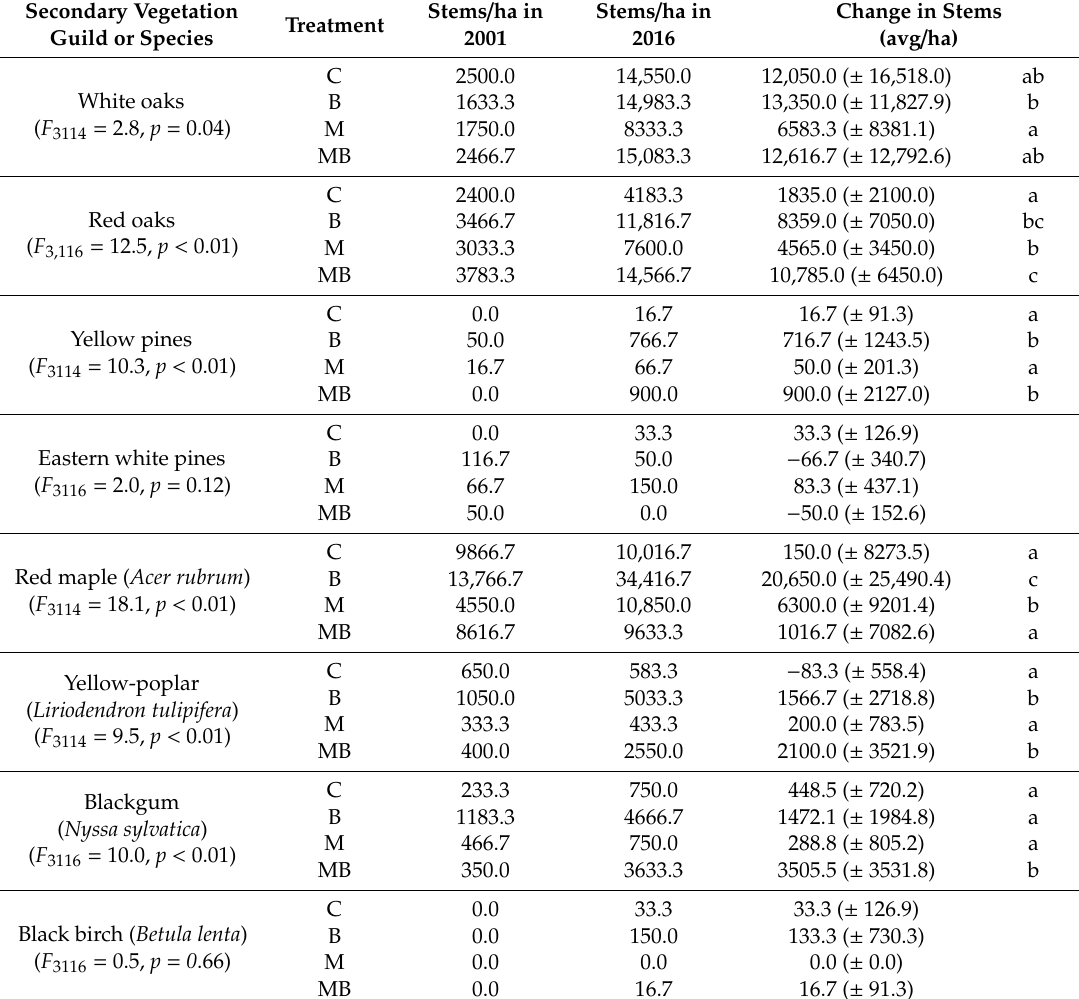
Table 3. Change in abundancy for the secondary vegetation guilds after 15 years (2001–2016) of repeated treatments (control = C, burned = B, mechanical removal of stems <10 cm in diameter at breast height (DBH) = M, and mechanical removal of stems <10 cm DBH + burned = MB). Means, standard deviations, and p ‐ values for each ANOVA are indicated in parentheses next to each guild. Lowercase letters identify the statistically different treatment effect at p < 0.05.